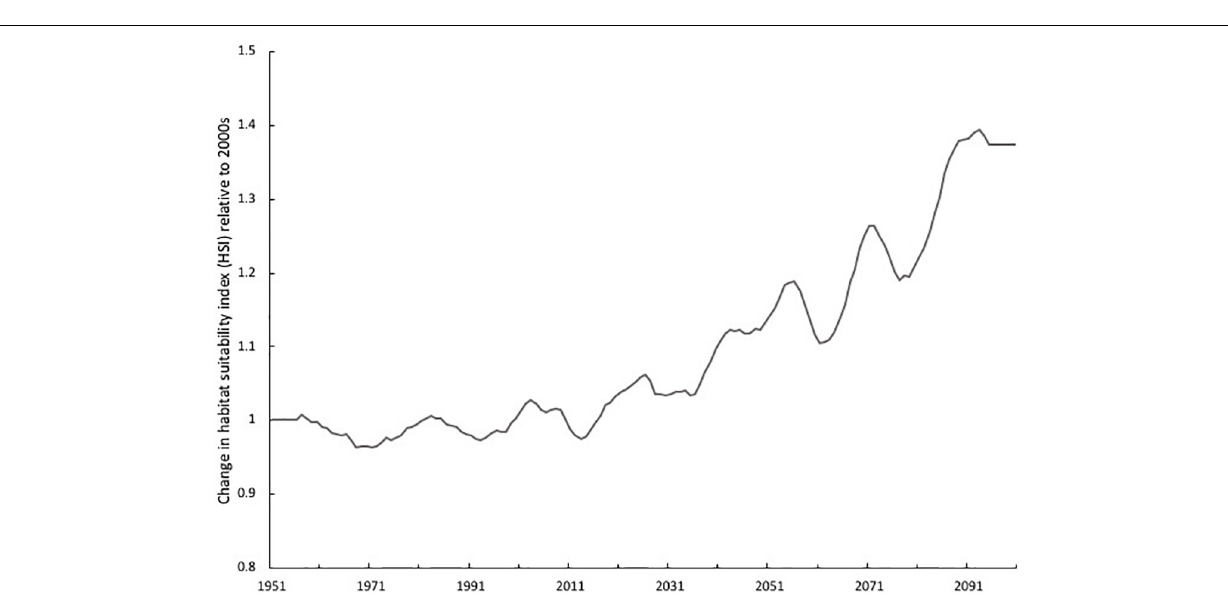
right to fish in Russia’s Economic Exclusive Zone, and that negotiations with Russia could be strained. One